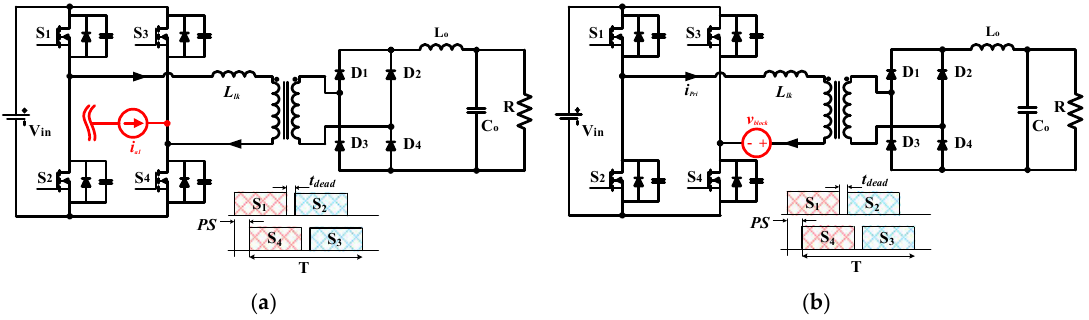
Figure 1. ( a ) Auxiliary current source to achieve zero-voltage switching (ZVS) of lagging-leg switches; ( b ) blocking-voltage source for the reset of the primary current.